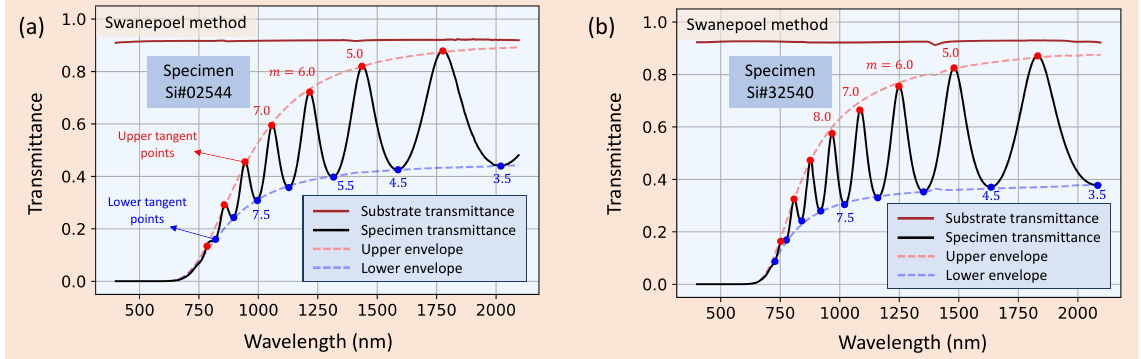
Figure 6. Application of the Swanepoel technique as elaborated in the text: Using the as-measured normal-incidence transmission spectra of ( a ) Si#02544 and ( b ) Si#32540 a -Si thin-film samples, and that of the finite glass substrate alone. The two constructed, top- and bottom-transmission envelopes, are also displayed for the two a -Si specimens. Moreover, some exact values of the interference order, m , are indicated in this figure in order to illustrate the model-free Swanepoel